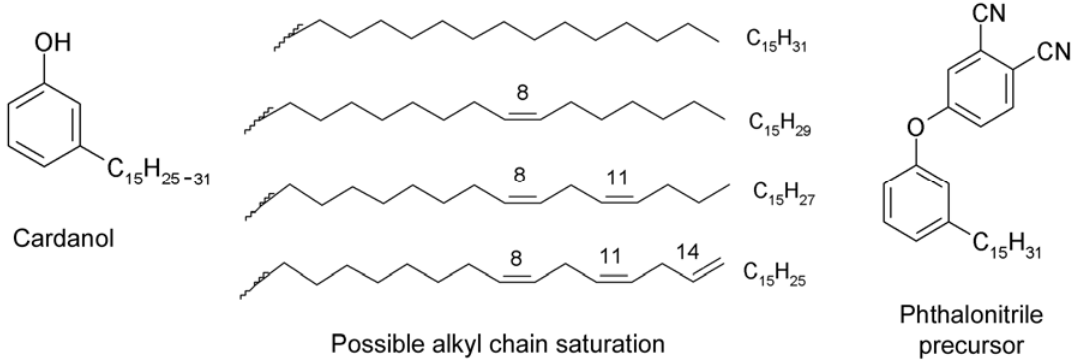
Figure 3. Cardanol and the phthalonitrile